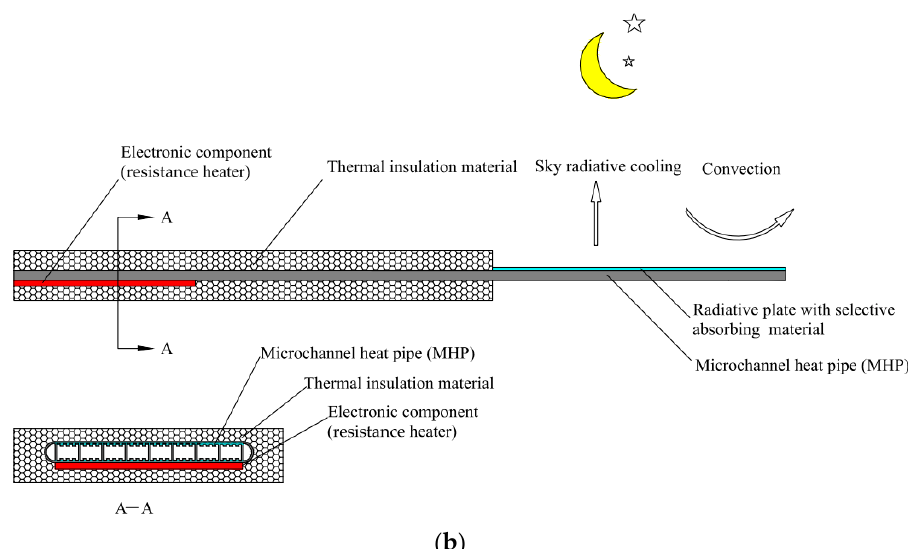
Figure 1. The unit of the novel MHP-RC (radiative and convection) system: ( a ) the aerial view and the ( b ) overall structure chart.